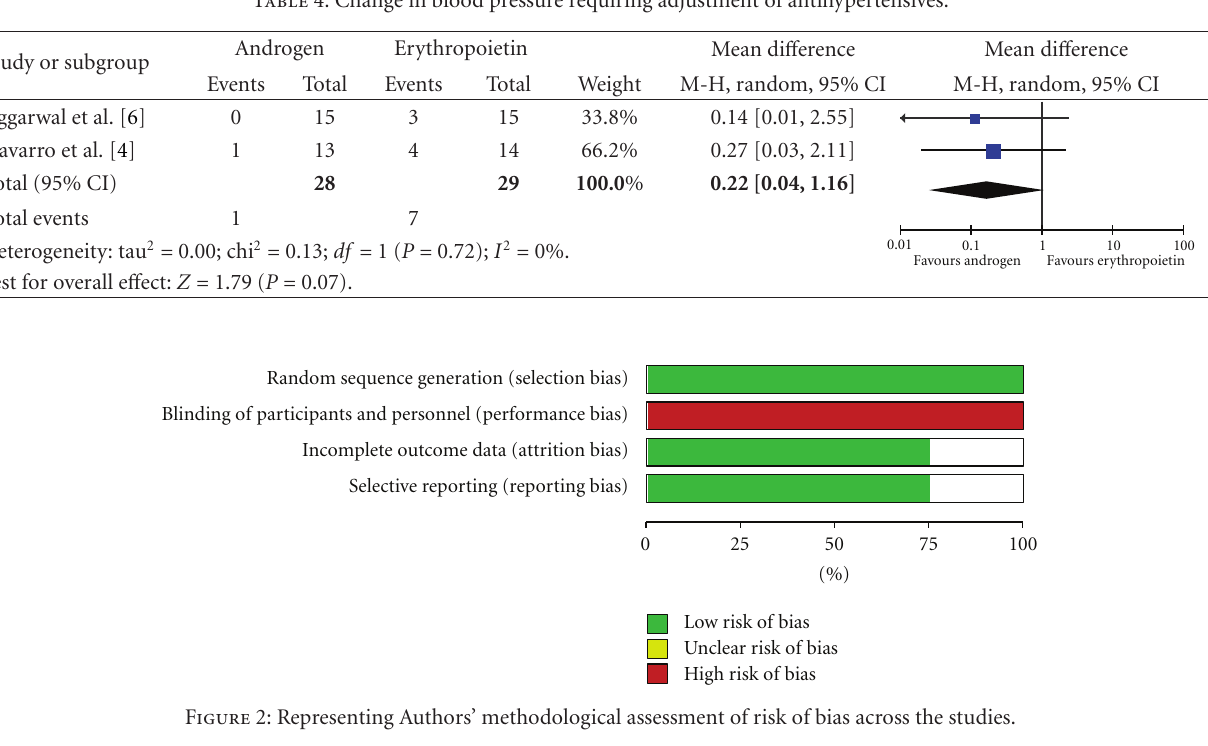
Table 4: Change in blood pressure requiring adjustment of antihypertensives.